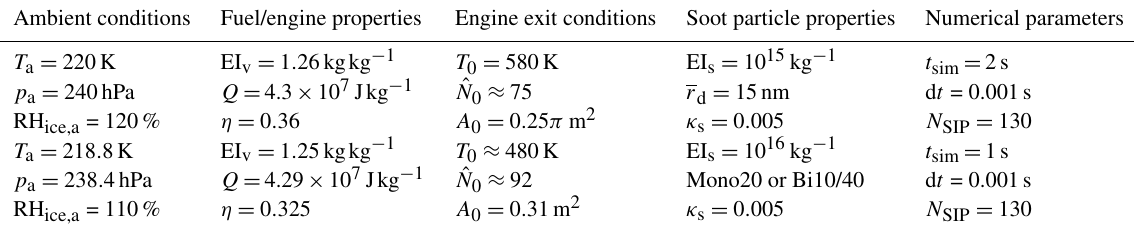
Table 1. Baseline parameters of all regular LCM simulations (first three rows) and those corresponding to the box model set-up of Lewellen (2020) (last three rows). Hereby, Mono20 stands for a monodisperse distribution with r d = 20nm and Bi10/40 for a bidisperse distribution with a 50 / 50 mixture of 10 and 40nm particles.